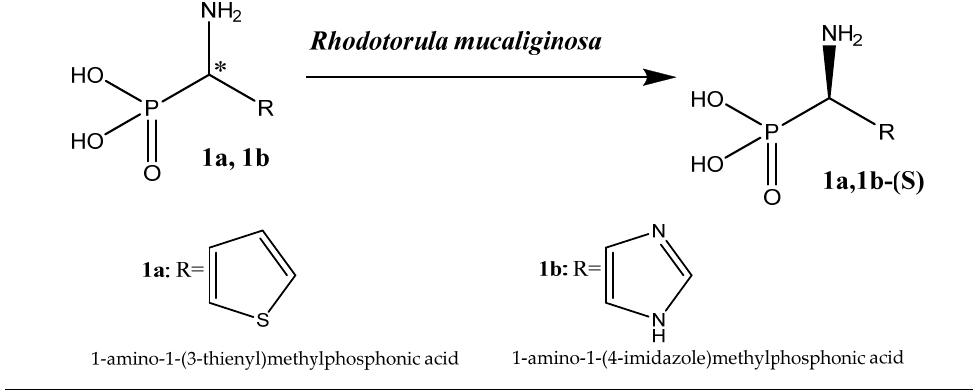
Table 1. Kinetically controlled resolution of racemic mixture of heterocyclic phosphonates with R. mucilaginosa assistance. Based on [15] with permission; copyright BioMed Central Ltd 2021.